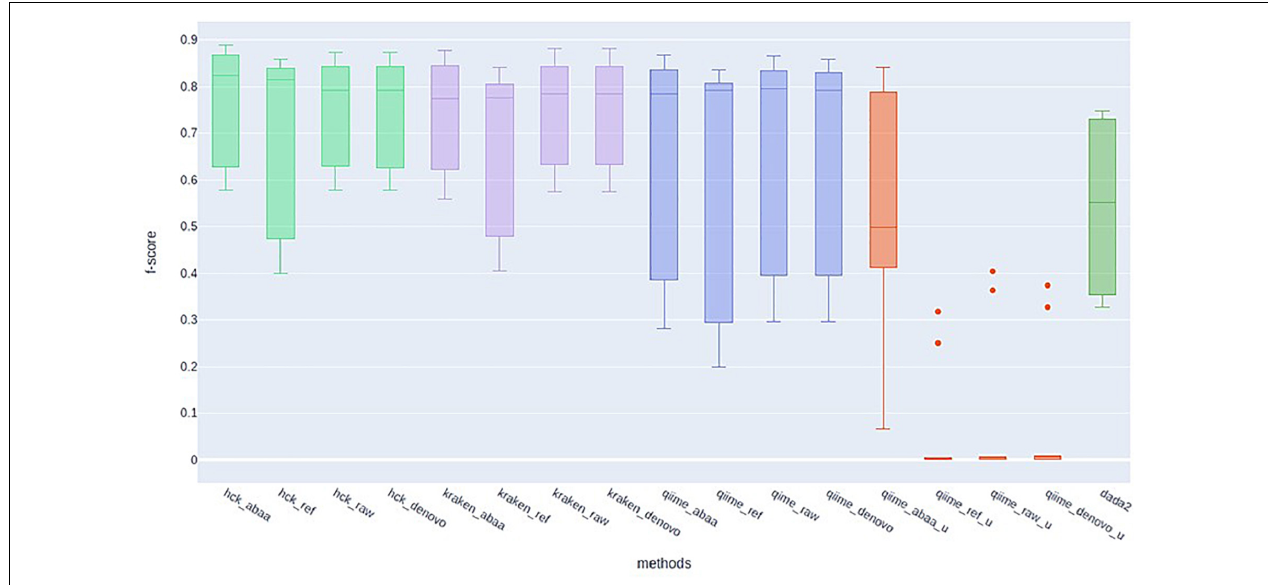
FIGURE 4 | F-score performance of HCK (light green), Kraken (mauve), Qiime with ITSdb (blue), Qiime with Unite database (red), and DADA2 (green).